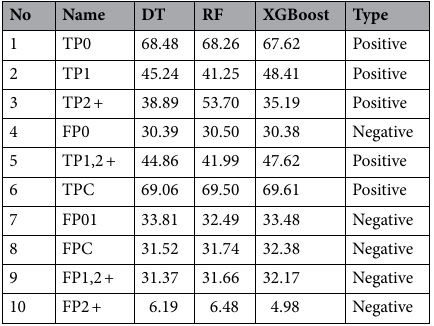
Table 7. Evaluation summary for the three developed models.